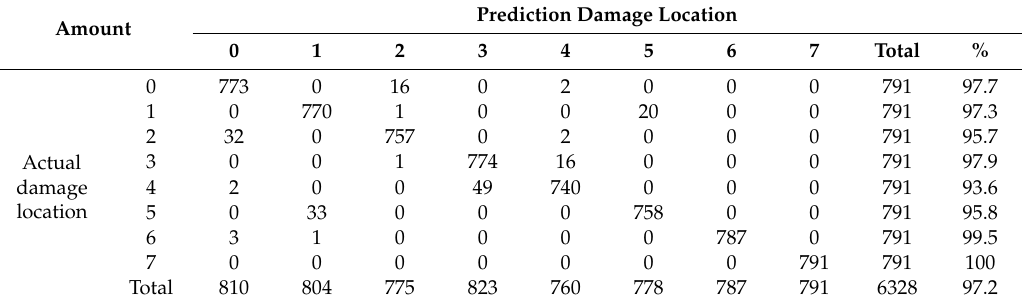
Figure 14. Training process of dataset D. Table 8. Detection results of dataset D.